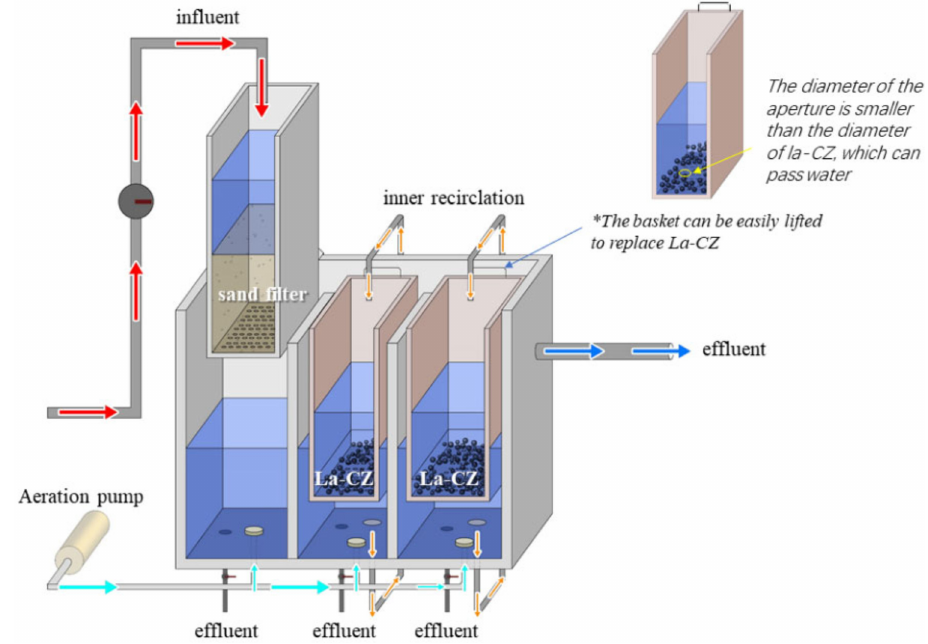
Figure 8. The introduction diagram of the Phosphorus Removal